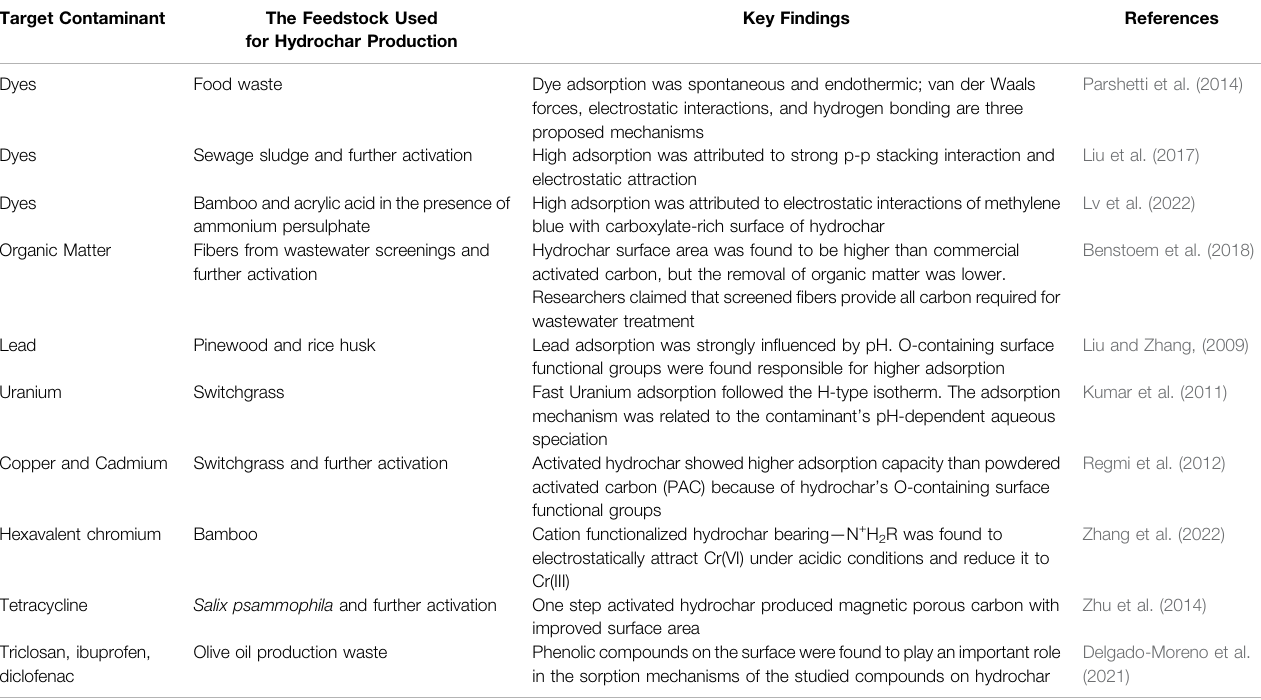
TABLE 1 | Selected studies on aqueous contaminant removal using hydrochar. Target